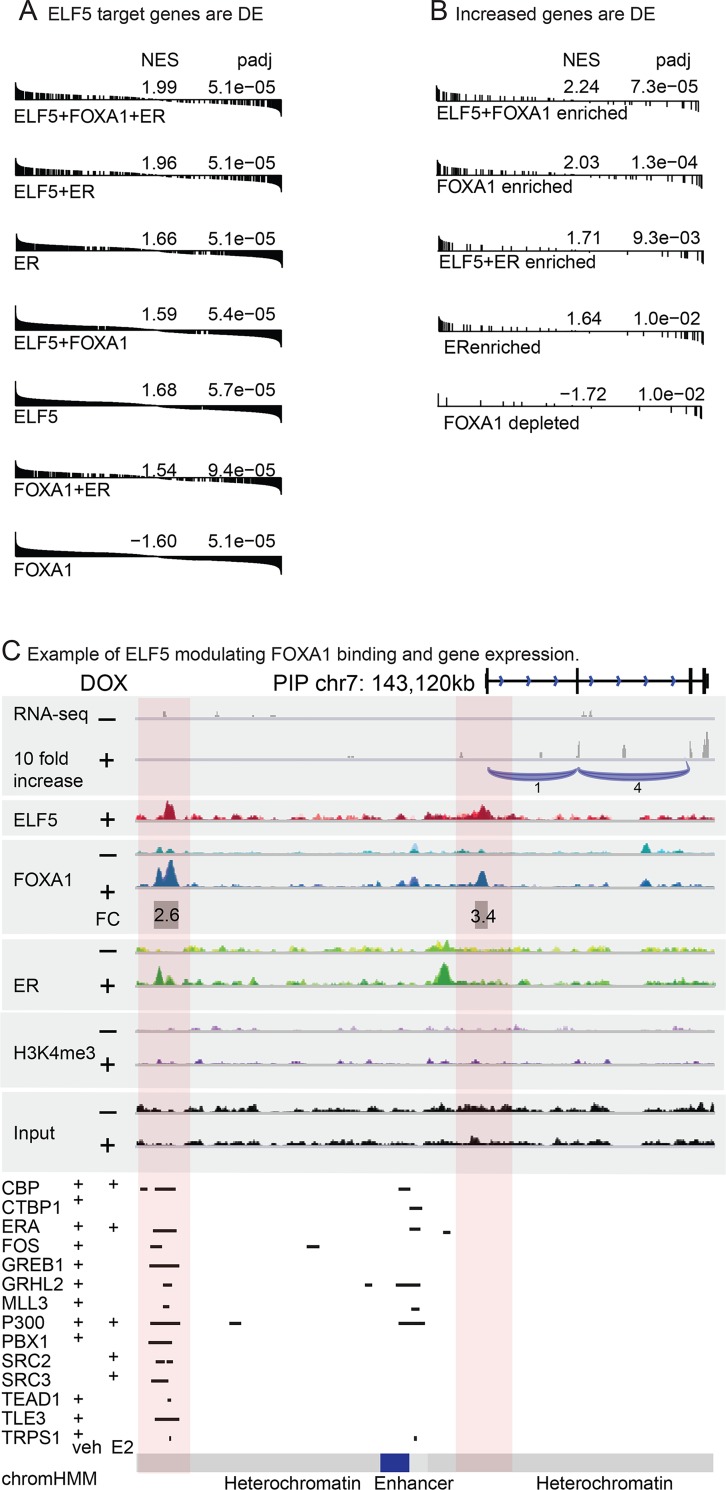
Changes in ELF5, FOXA1 and ER binding to the genome are reflected in gene expression.Panel A, Expression of genes identified by GREAT as ELF5, ER or FOXA1 transcriptional targets, showing their position in the distribution of differential expression (DE) in the RNA-seq data in response to induction of ELF5. GSEA-type visualization, nominal enrichment score (NES) and corresponding FDR (padj) are shown (R package fgsea). Panel B, as for panel A but showing genes for which FOXA1 or ER binding was increased or decreased by induction of ELF5. Panel C, coding-region of an ELF5-regulated gene involved in endocrine resistance (PIP) showing differential gene expression by RNA-seq, (exon splicing in blue) and increased FOXA1 binding by ChIP-seq at 2 locations with fold change (FC) shown, in response to induction of ELF5 with doxycycline (+) compared to vehicle (-). Binding of the indicated transcription factors to this locus from reported ChIP-seq experiments is shown together with the chromHMM model [61].